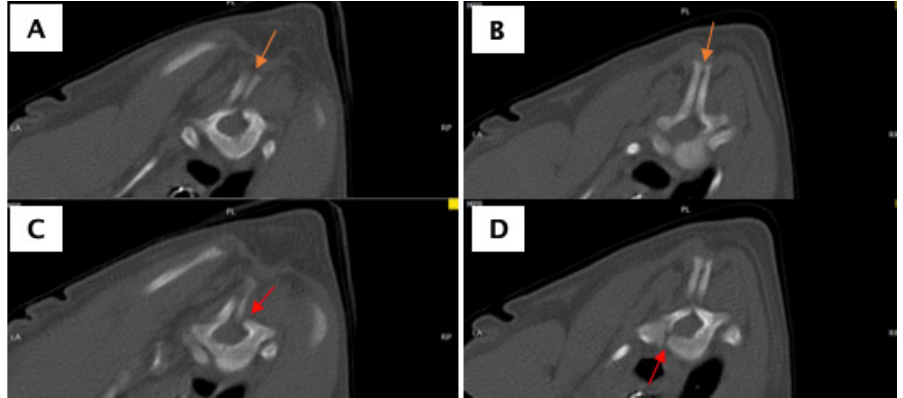
Figure 4. CT images of the cranial segment of the thoracic spine (T2 and T3 vertebrae) of a 3-month-old male MBD dog, with congenital vertebral malformations. (Veterinary Hospital/UFRRJ – August/2019) Note. A and B) CT image of the cranial segment of the thoracic spine , with helical acquisition and 2.0 mm cross-section, showing morphological changes associated with slight modification of the shape of the vertebral bodies of T2 (A) and T3 (B) , with complete median dorsal hypoplasia of the respective spinous processes (spina bifida) (orange arrows). C and D) CT image of the cranial segment of the thoracic spine , with helical acquisition and 2.0 mm cross-section, showing focal areas of discontinuity in the blade of the right dorsal arch of T2 (C) and in the pedicle of the left vertebral arch of T3 (D) (red